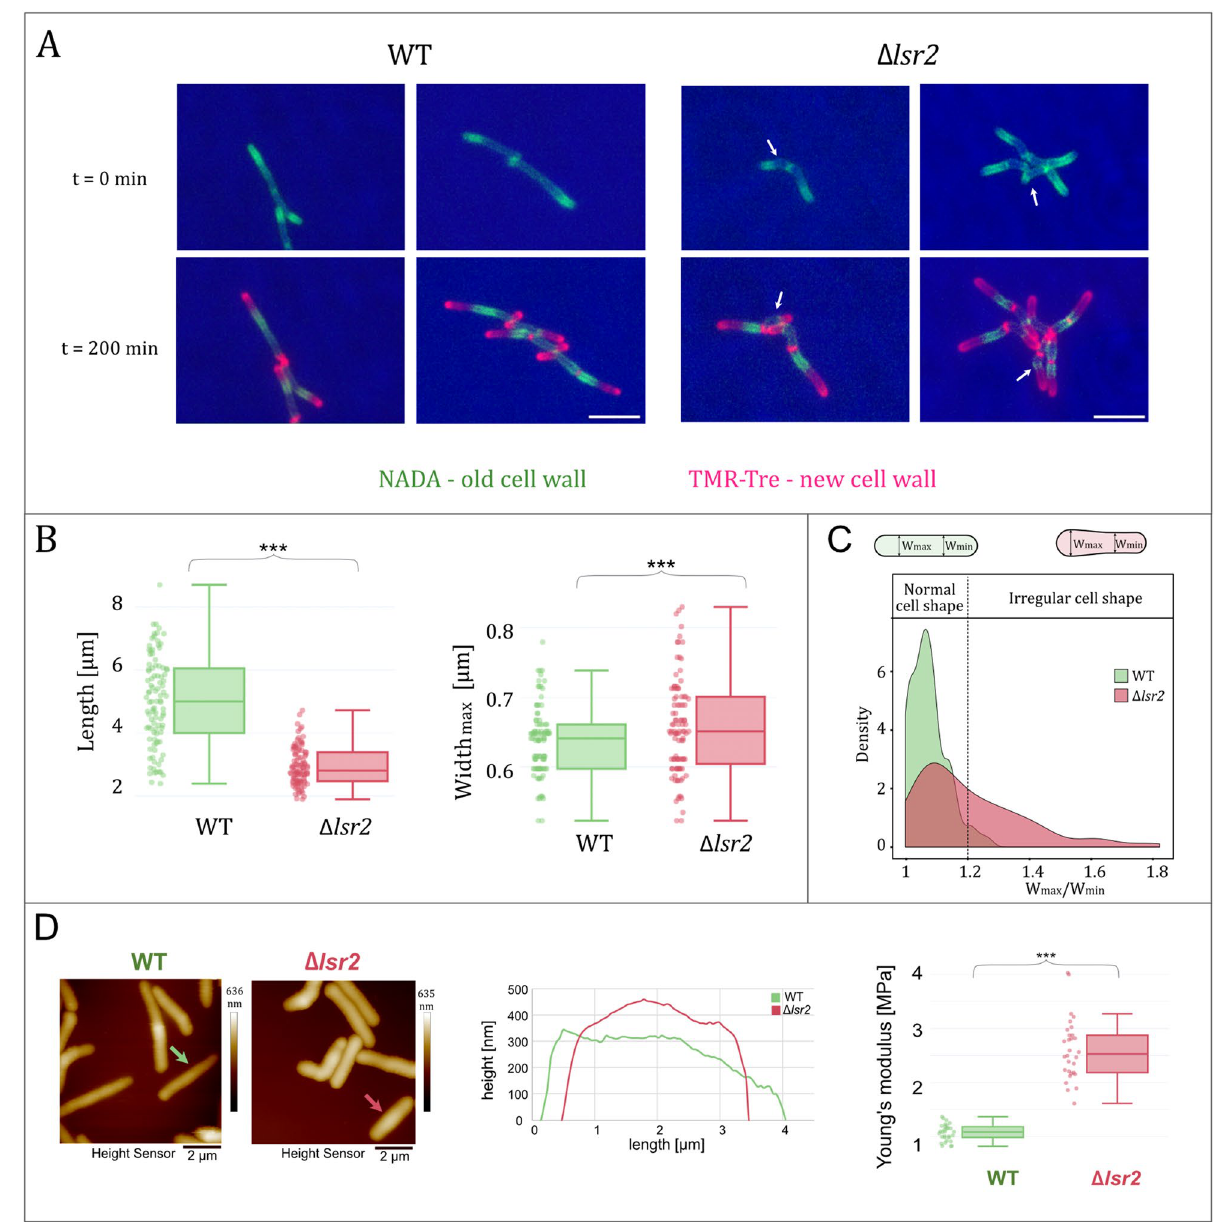
Figure 1. Influence of lsr2 deletion on mycobacterial cell morphology and elasticity. ( A ) Micrographs showing representative cells of the WT and Δ lsr2 labeled with NADA and TMR-Tre dyes. White arrows point to morphological disorders of the Δ lsr2 cells. Bar 5 µm. ( B ) Comparison of the cell length (left) and width (right) between the wild-type M. smegmatis mc 2 155 (WT) and Δ lsr2 strains (n = 100). Statistical significance was defined as ***p < 0.0005 (parametric double-sided t test with pooled SD). ( C ) Distribution (shown as the probability density function) of the width ratio (measured between the thickest (W max ) and the thinnest (W min ) part of a given cells) in WT and Δ lsr2 cells (n = 100 each). ( D ) Height sensor images of WT and Δ lsr2 cells (left panel). The height profiles of representative cells of each strain (middle panel) are indicated by the green and red arrows, respectively. Young’s modulus (a measure of elasticity) were compared for WT and Δ lsr2 cells. Five uniformly spaced points were selected on each bacterial cell to make measurements [n = 30, right panel; statistical significance was defined as ***p < 0.0005 (parametric double-sided t test with pooled